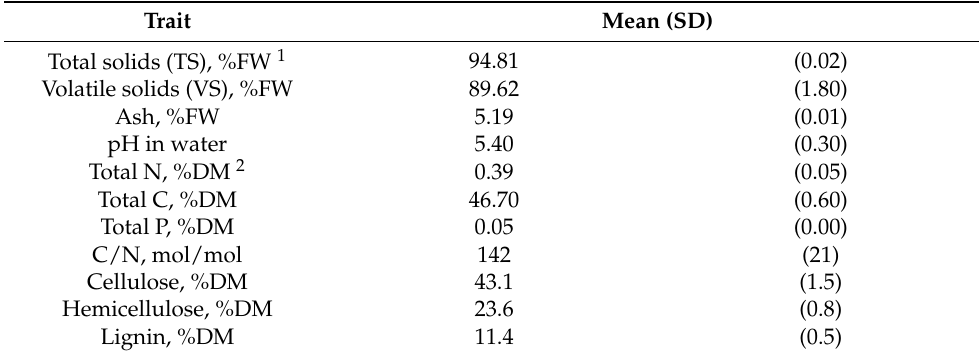
Table 1. Fiber composition and other quality traits of the dry milled giant reed